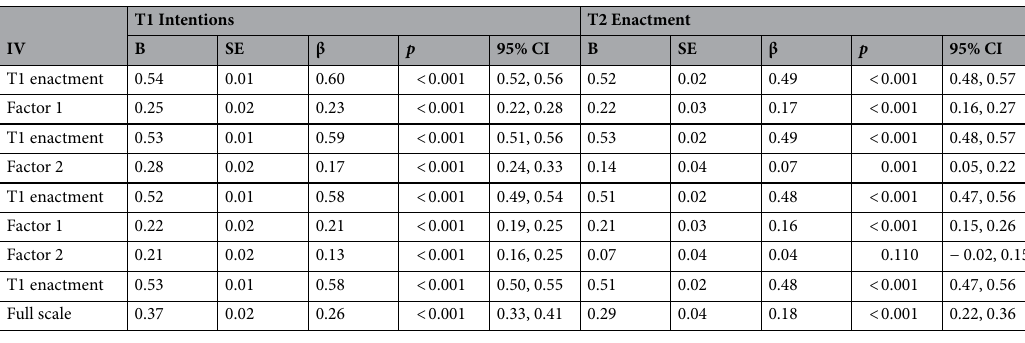
Table 3. Regression analyses assessing the relationship between AMPES factors and (i) T1 PBS enactment intentions and (ii) T2 PBS enactment. Enactment intentions were measured on a scale of 1 ( Very unlikely ) to 5 ( Very likely ). A Do not intend to drink alcohol option was also provided (treated listwise). Enactment was measured on a scale of 1 ( Never ) to 5 ( Always ). A Not applicable option was also provided (treated listwise). T1 = Time 1. T2 = Time 2.